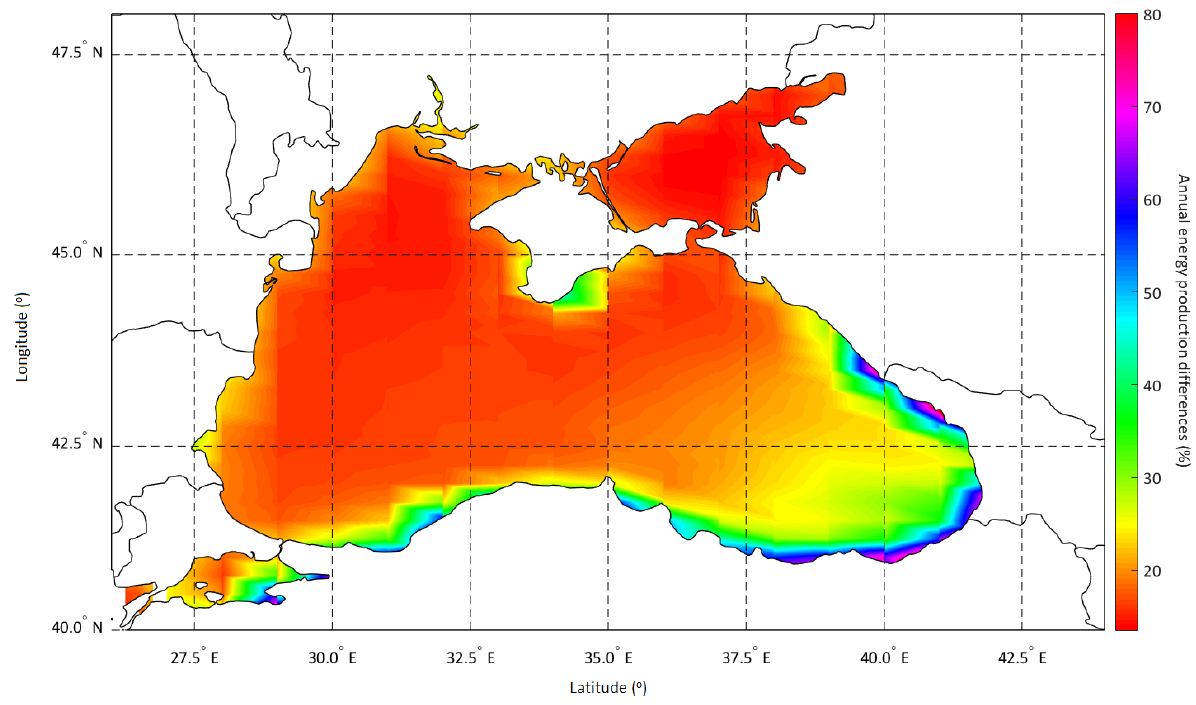
Figure 15. Differences (in %) reported between the expected AEP of a wind turbine and AWES system (U414) defined by a rated capacity of 5 MW.